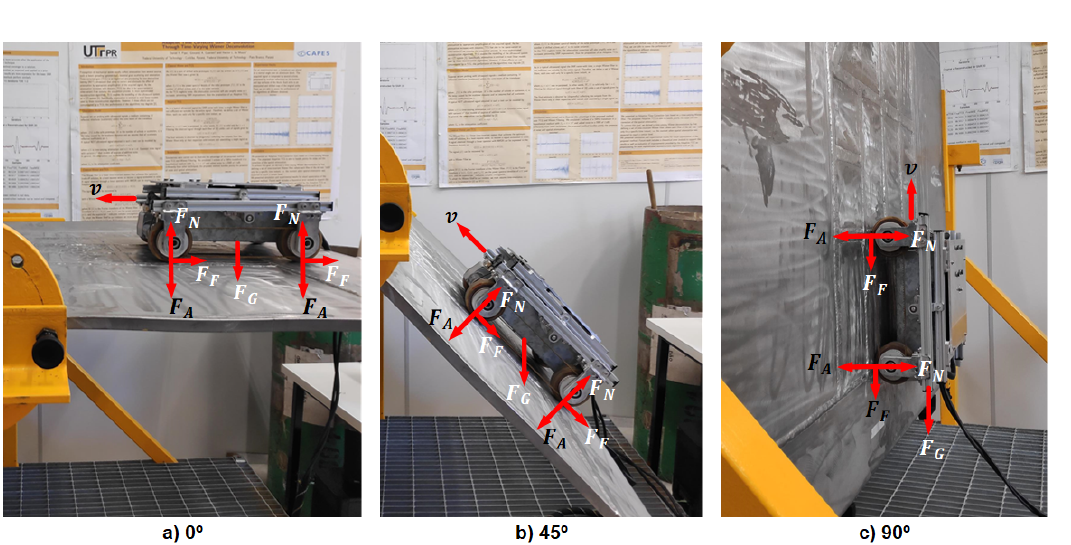
Figure 1. Force analysis between a climbing robot and the contact plane (wall) with different inclination angles: ( a ) 0 ◦ wall ( b ) 45 ◦ wall ( c ) 90 ◦ wall. The forces present in the figure are: F G is the gravity force, F F is the frictional force, F N is the normal force, and F A is the adhesion